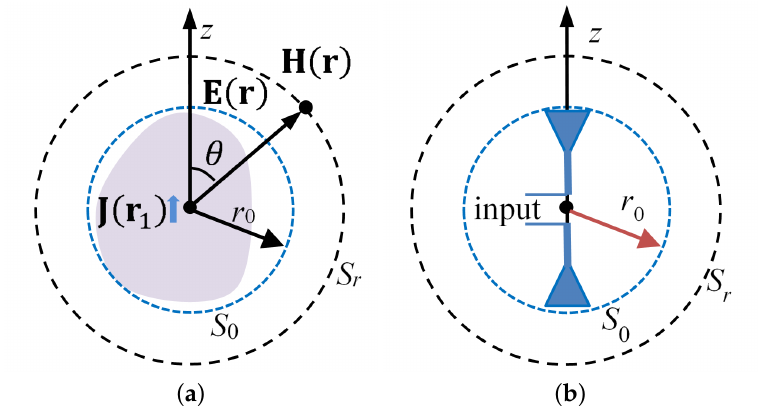
Figure 1. The electromagnetic radiation. ( a ) A source in a bounded region; ( b ) antenna with symmetrical